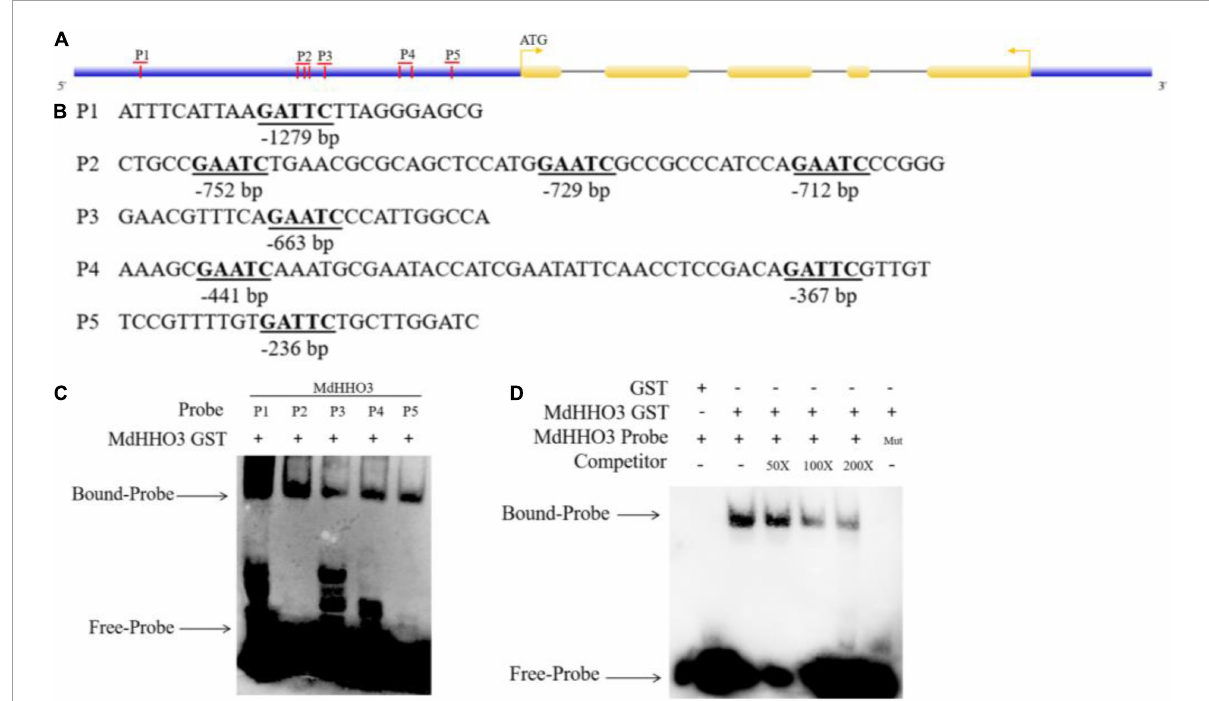
FIGURE4 MdHHO3 binds to a specific sequence of its own promoter. (A) Diagram of the MdHHO3 gene promoter region. A vertical bar represents the potential sites to which MdHHO3 may bind. (B) GAATC and GATTC motifs in the promoter region selected in the DNA-binding site. (C) The electrophoretic mobility shift assay (EMSA) showed that the MdHHO3-GST fusion protein binds to the labeled DNA probe. (D) EMSA results showed that MdHHO3 binds to the labeled probe of the MdHHO3 promoter. The MdHHO3-GST fusion protein was incubated with a labeled or mutated probe DNA fragment. The labeled probe used in this study is p1 (5 (cid:48) -ATTTCATTAAGATTCTTAGGGAGCG-3 (cid:48) ). The unlabeled probes were used as a competitor. 50 × , 100 × , and 200 × represent the rates of the competitor. “Mut” representing the mutated probe in which the 5 (cid:48) -GAATC-3 (cid:48) motif was replaced by 5 (cid:48) -CAATG-3 (cid:48) . The – symbol indicates absence, and the + symbol indicates presence.